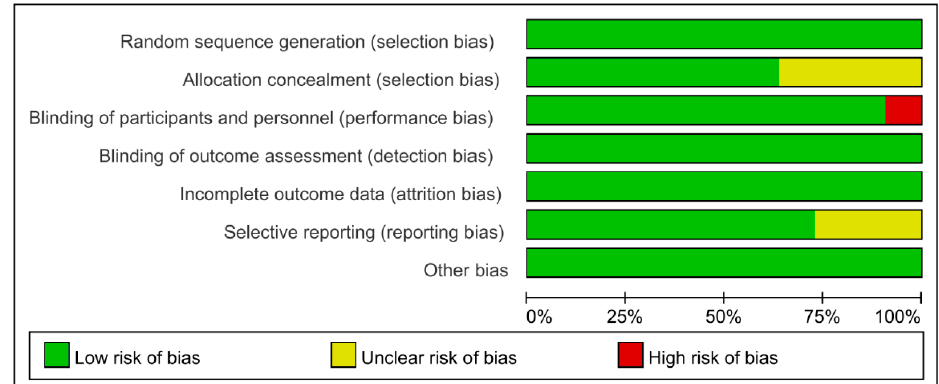
Figure 2. Risk of bias for included studies.